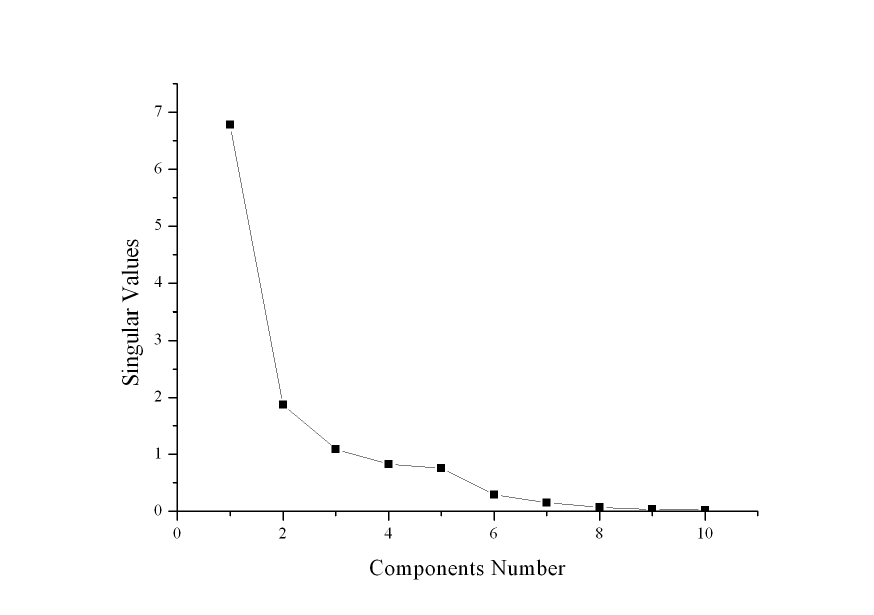
Fig. 1 Scree plot of the singular values.